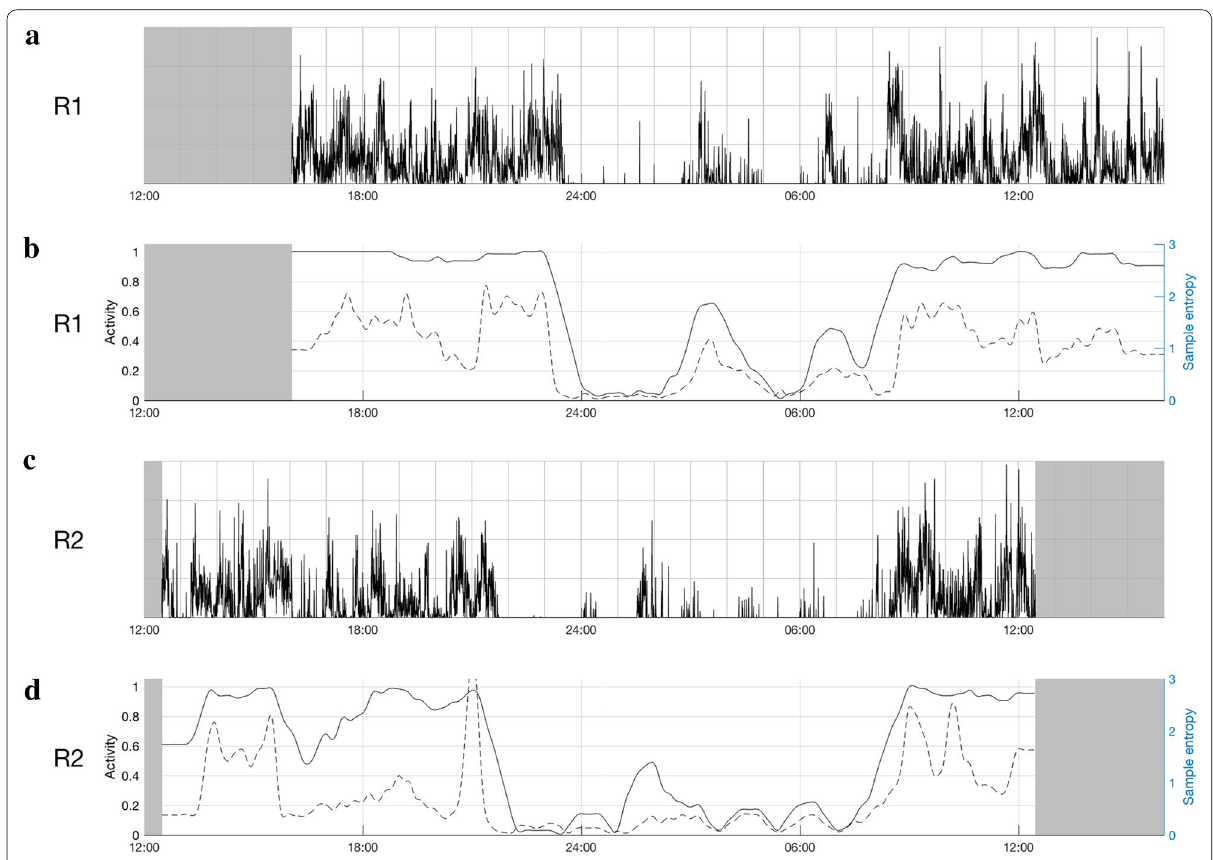
Fig. 1 Actigraphy data for two admissions for mania with psychotic symptoms (case 1). a , b Represent the first recording (R1) and c , d the second recording (R2). Time of day is shown at the bottom of each chart (24‑h clock). Light grey parts at the beginning and end of each chart represent non‑monitoring time; a , c are 24‑h actograms: activity counts are shown as black, vertical lines on a scale from 0 to 500 counts. One square in the grid represents 1 h on a horizontal axis and 125 counts on a vertical axis. b , d The ratio between rest and activity as the fully drawn line (left axis) and sample entropy as the dotted line (right